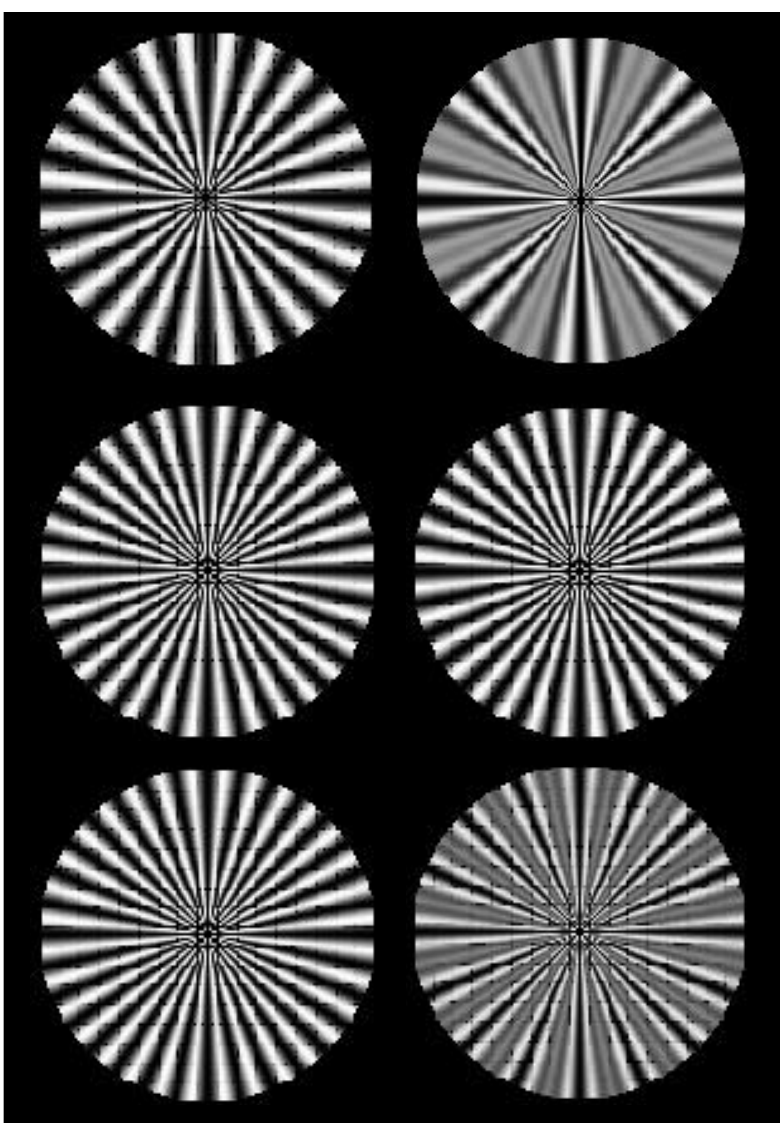
Figura 1. Exemplos de pares de estímulos de freqüências angulares utilizados para estimar o filtro angular de 32 ciclos. Acima à esquerda a freqüência de 24 ciclos e à direita 24 ciclos somada à 32 ciclos, ao centro à esquerda 32 ciclos e à direita 32 ciclos somada à 32 ciclos e embaixo à esquerda 48 ciclos e à direita 48 ciclos